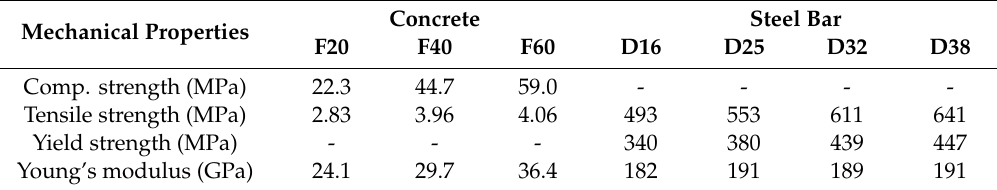
Table 2. Mechanical properties of the materials.